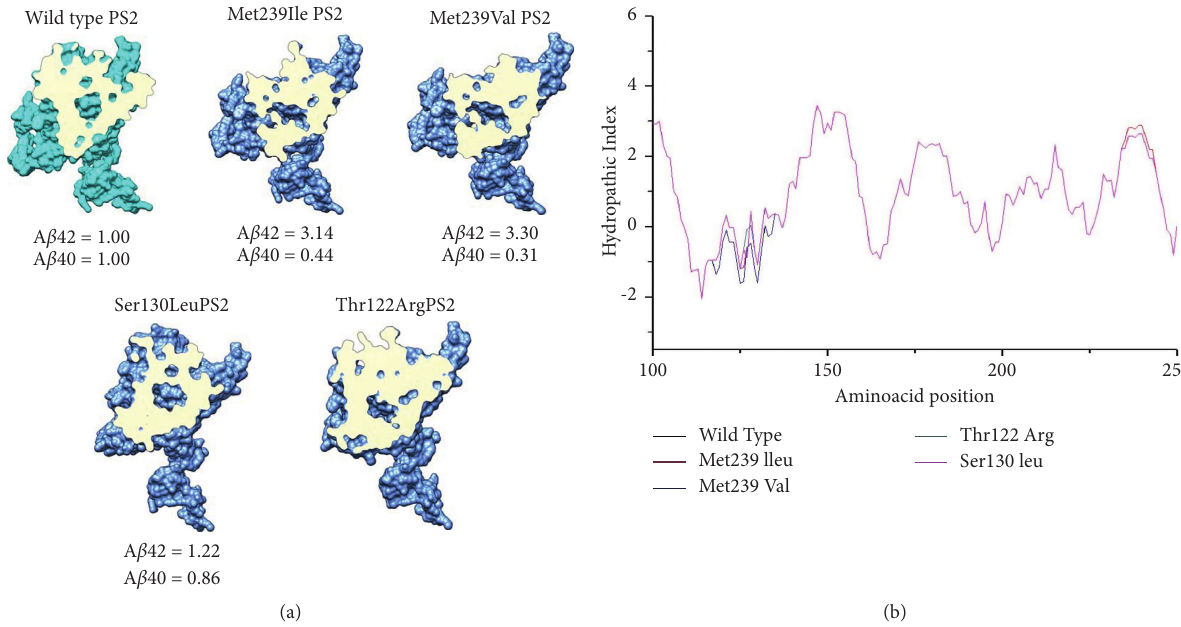
Figure 5: Analysis of selected mutations from various approaches. (a) Top view of the cross sections of the wild-type PS2 (pale blue), and the two mutations Met239Ile and Met239Val that affect the canonical function analyzed in the pore (dark blue). (b) Hydropathic index of the mutations evaluated in